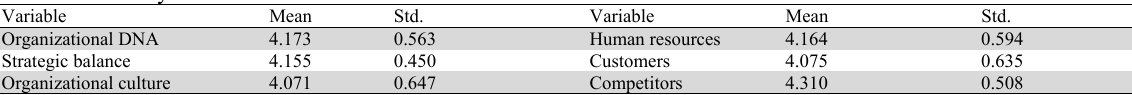
Means of the study’s variables